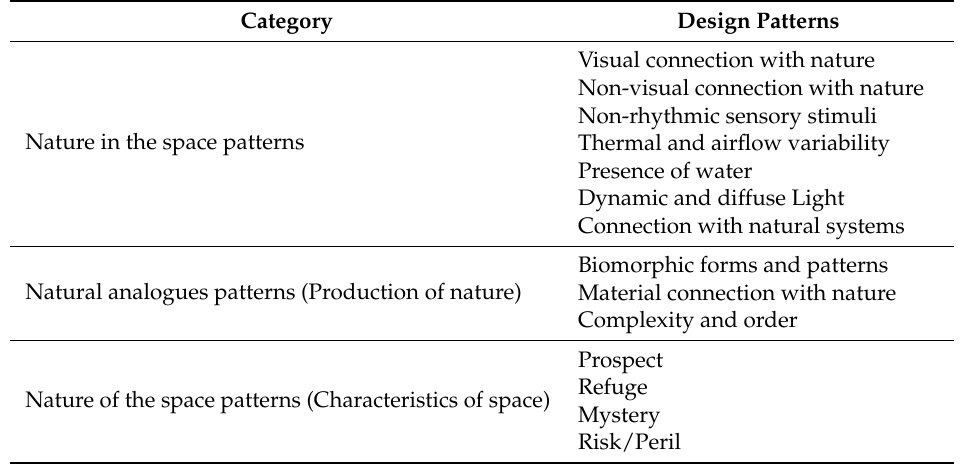
Table 3. Biophilic design patterns (Adapted from Browning, Ryan & Clancy, 2014 [49] and Lee and Park, 2018